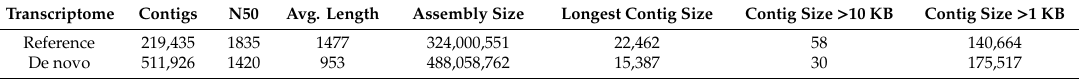
Quality evaluation of the samples: ( A ) library size of the sequenced wheat lines; ( B ) boxplot of logCPM expression values across the samples; ( C ) principal component analysis (PCA); and ( D ) multidimensional scaling (MDS) plot of the Trimmed Means of M-values (TMM) normalized expression values of samples. Resistance, susceptible and control lines are represented through red, green and blue colours, respectively. Control lines (cont): blue, resistant lines (Res): red, susceptible lines (Sus): green. Table 1. Assembly metric of the reference and de novo transcriptome